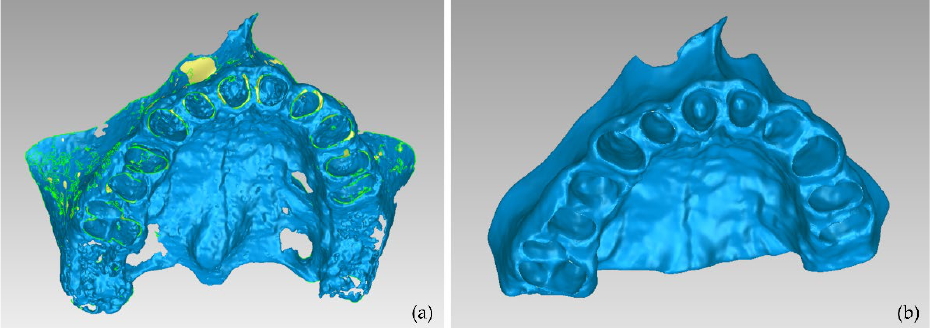
Figure 12. 3D model of the alveolar bone; ( a ): the result of Experiment 3 (automatic segmentation); ( b ) result of Experiment 2 (manual segmentation).